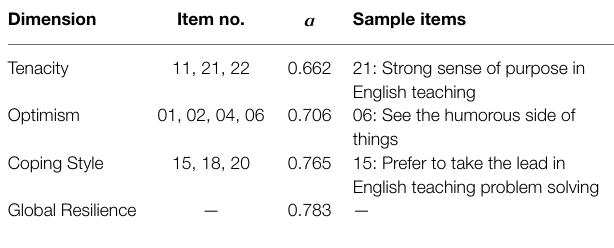
TABLE 1 | Basic information of the five interviewes.